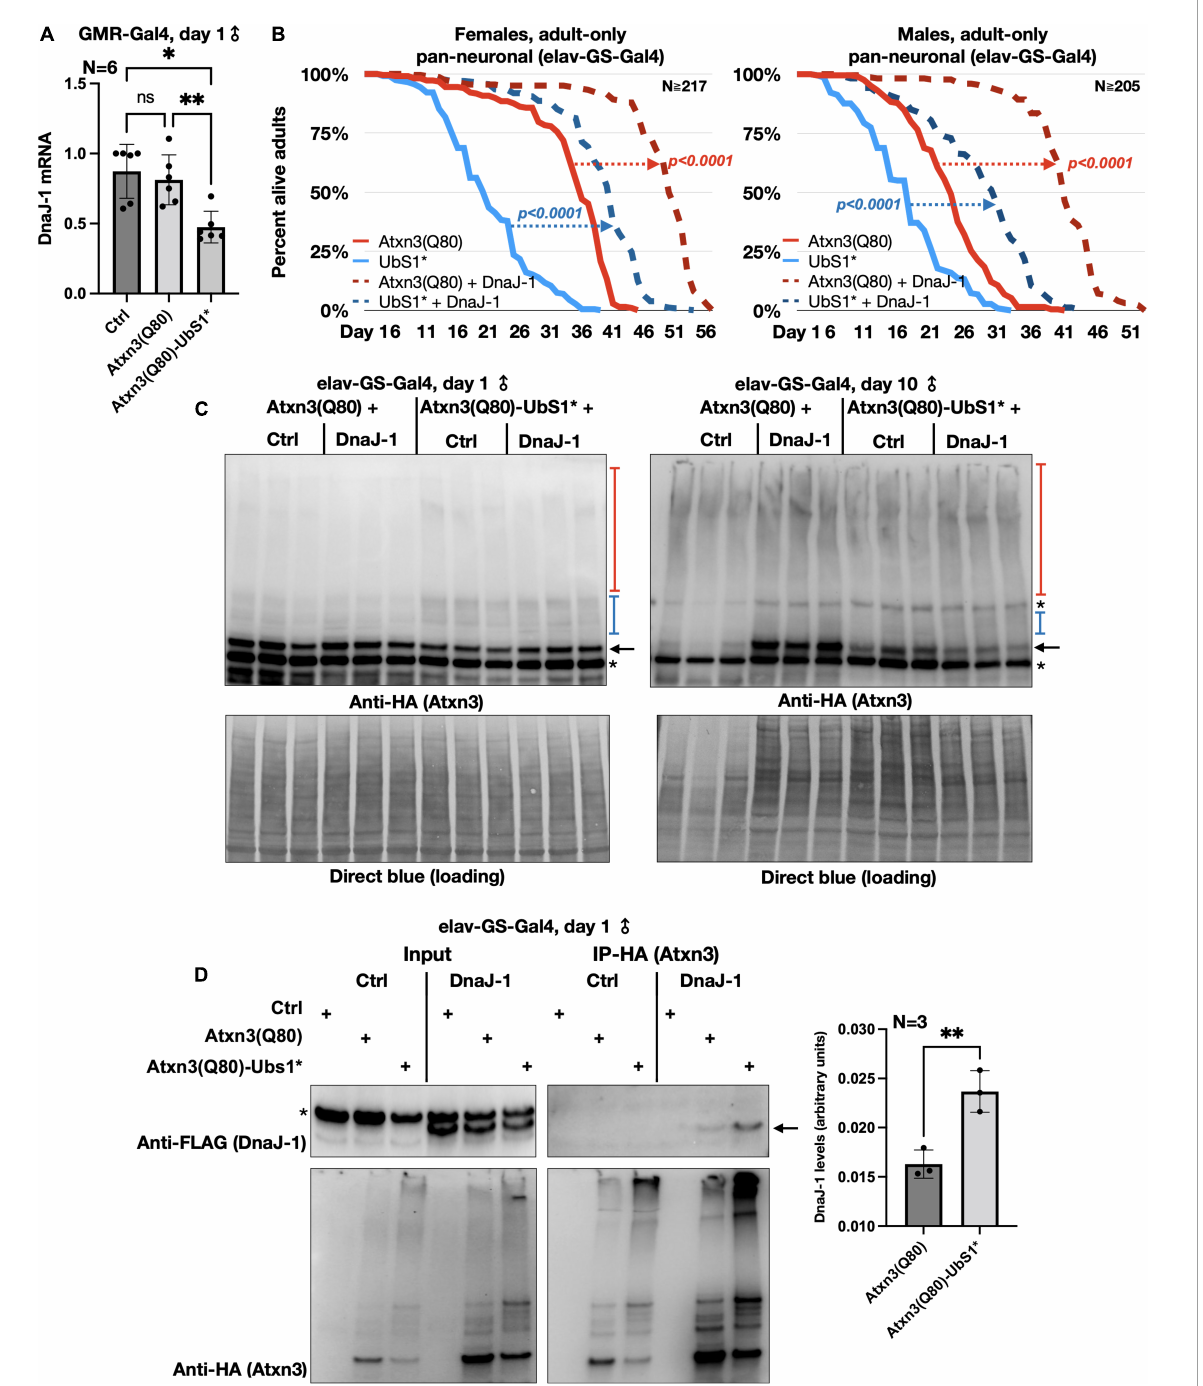
FIGURE4 DnaJ-1 suppresses neuronal toxicity from UbS1-mutated Atxn3 and binds it more strongly than Atxn3(Q80) with intact UbS1. (A) qRT-PCR from dissected fly heads expressing the noted versions of Atxn3. Ctrl: Gal4 driver on the background line of Atxn3 transgenic flies. ∗ p < 0.05, ∗∗ p < 0.01, “ns”, not significant. Statistics: One-way ANOVA with Tukey’s post hoc . (B) Adult fly longevities when Atxn3(Q80) with intact or mutated UbS1 was expressed in adult neurons in the absence or presence of exogenous DnaJ-1. P -values are from log-rank tests. (C) Western blots from whole flies expressing the noted transgenes in adult neurons for the indicated amounts of time. Black arrow, unmodified Atxn3 band. Blue bracketed bar, ubiquitinated Atxn3 species. Red bracketed bar, SDS-resistant Atxn3. Asterisks, non-specific signal. Ctrl: Flies expressing Atxn3 in the absence of exogenous DnaJ-1. (D) Left: Western blots of input and HA-IPs. Black arrow, DnaJ-1 band. Asterisk, non-specific signal. Right: Quantification of blots from the left and other, independent repeats. ∗∗ p < 0.01 from t